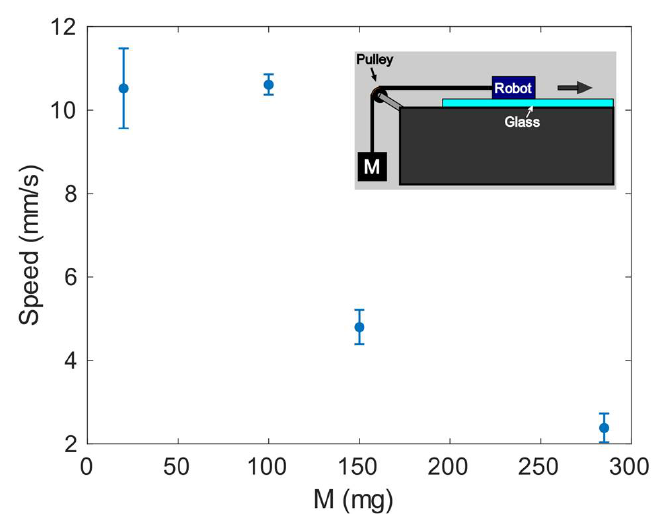
Figure 13. Speed versus pulled mass. Symbols represent the average of 3 measurements. Setup shown in the inset.